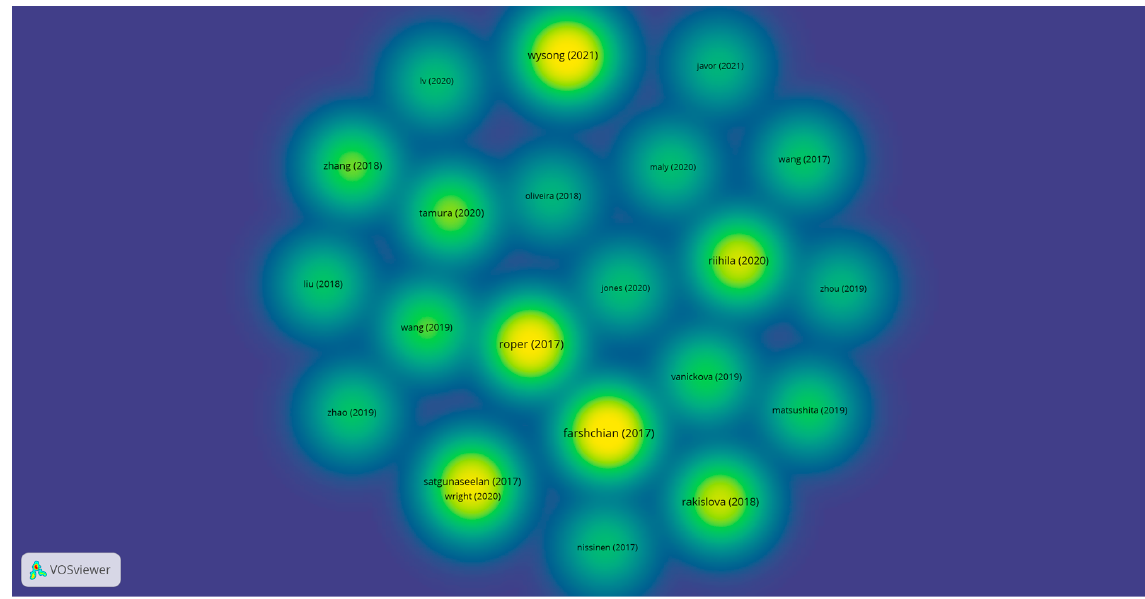
Figure 7. The citation density of the selected research articles from WoS *. (* Color legend: The intensity of the yellow–green colors represents the higher number of citations for the most-cited research articles out of those that were selected).